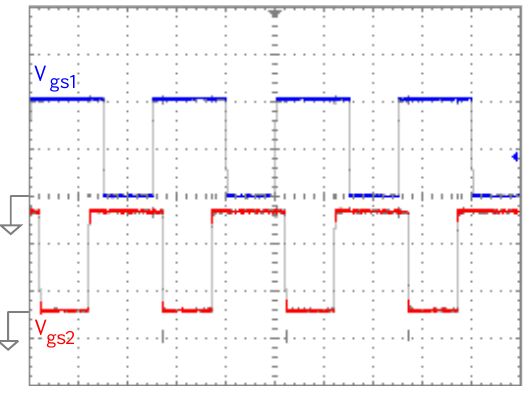
/ div = 5 V, Time / div = 10 µ s). D